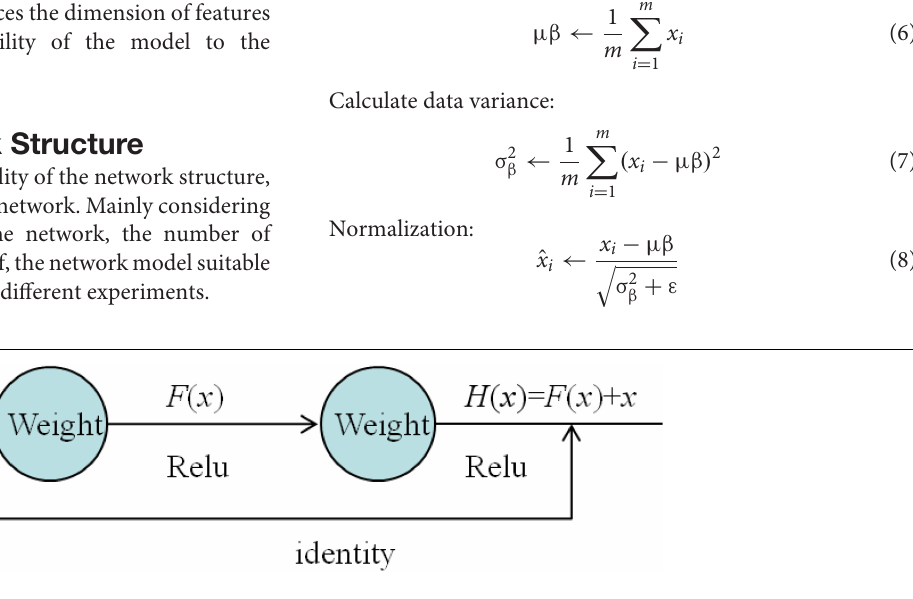
FIGURE 3 | Residual network